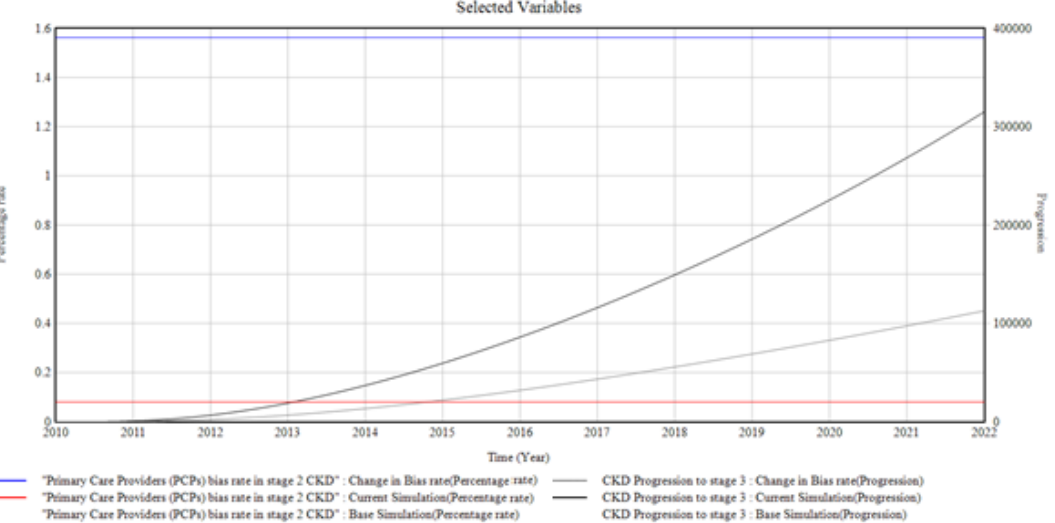
Figure 4. The bias in CKD treatment in stage 2 and the CKD progression to stage